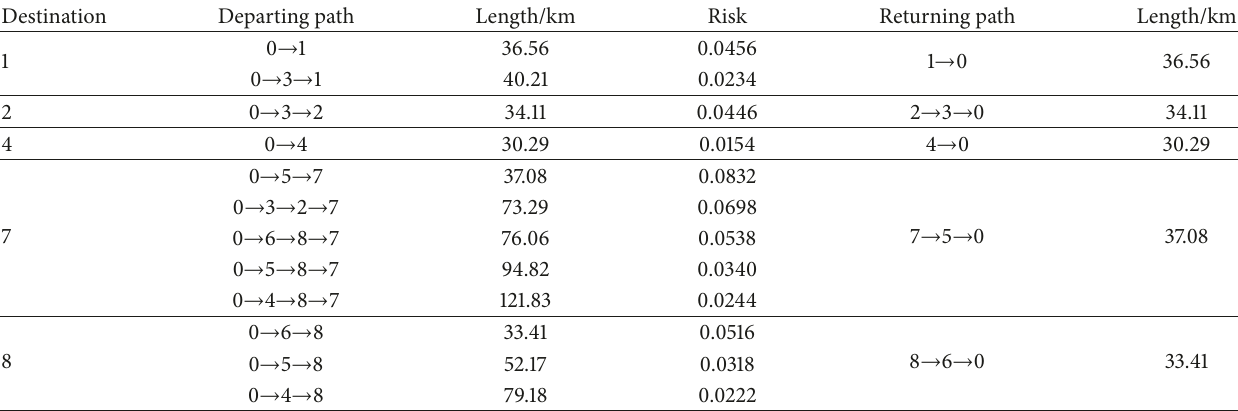
Table 3: Departing path and returning path between the distribution center and each destination.